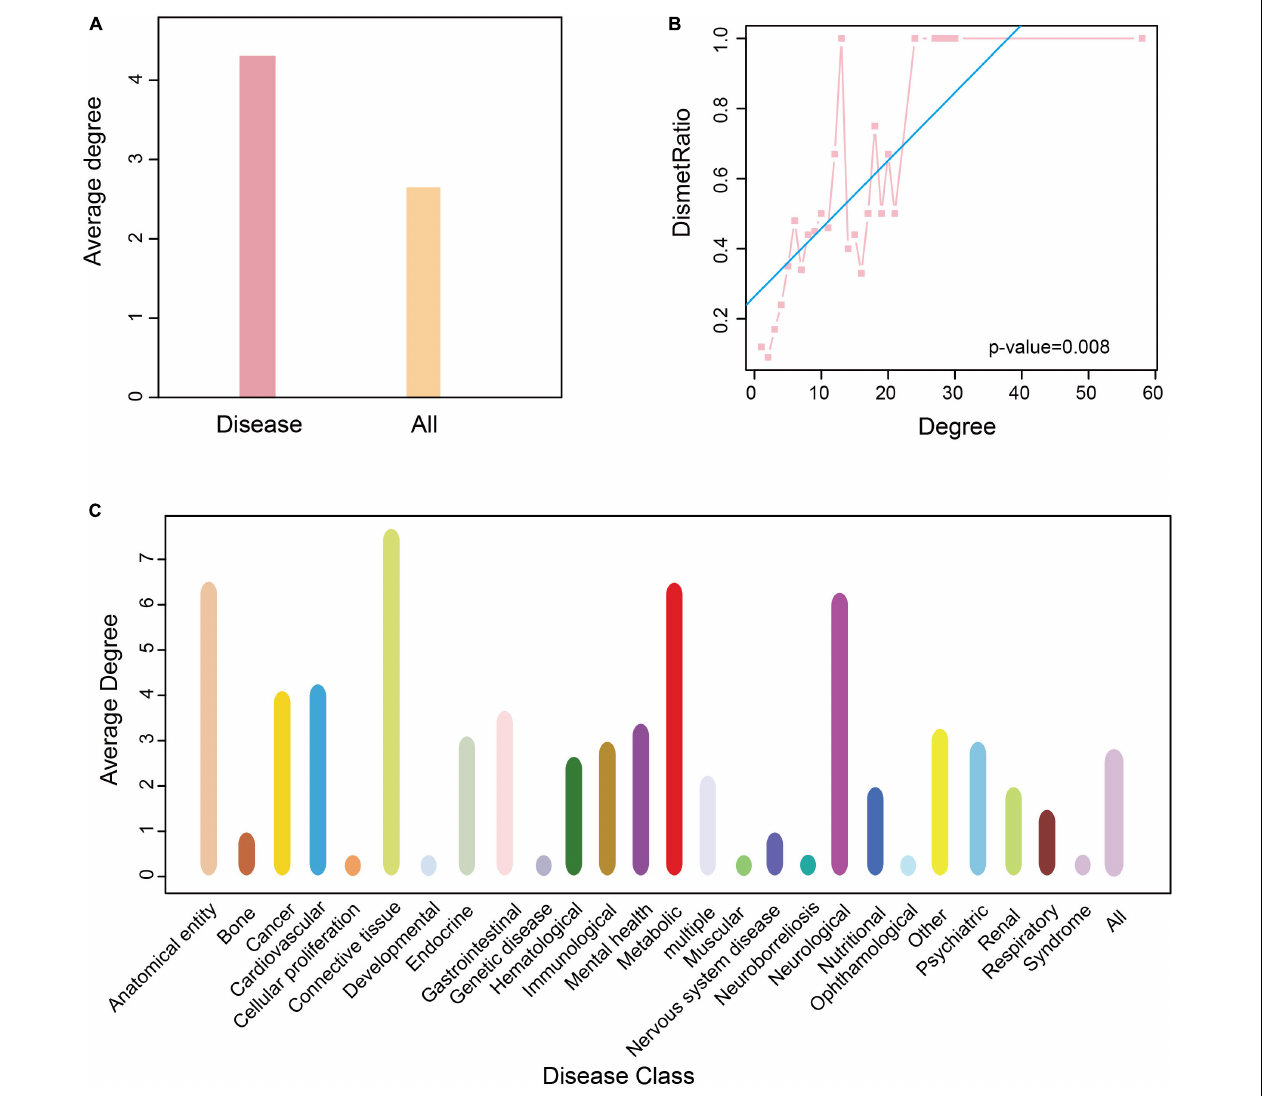
FIGURE 5 | Degree of nodes association in HDMN. (A) The average degree of all metabolite and disease nodes. (B) The correlation between proportion of disease-related metabolites and degree ( P -value = 0.008, F -test). (C) The average degree of metabolite in each disease class. The color of the disease corresponds to that of Figure 1